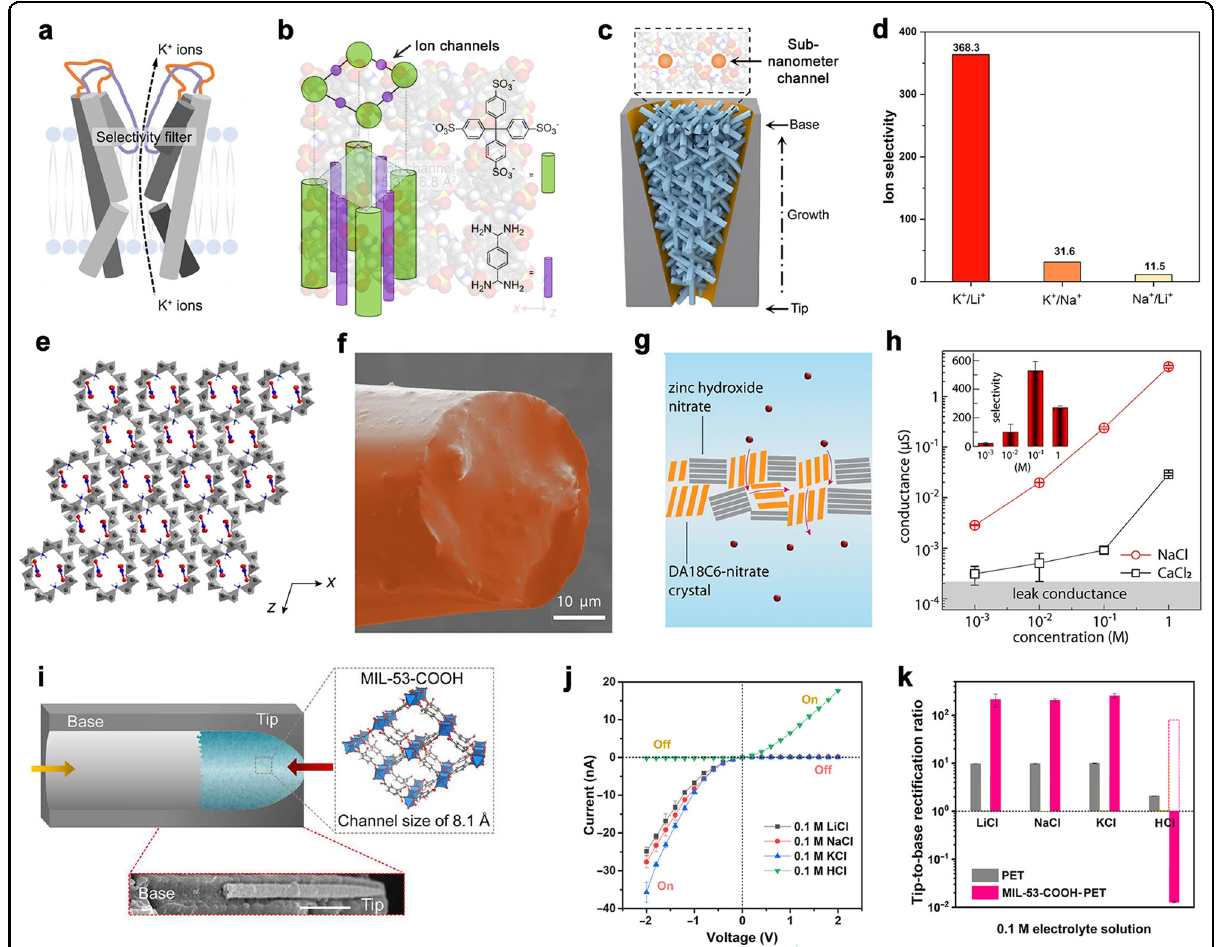
Fig. 3 Porous crystal-based arti fi cial nanochannels with pore-in-pore structures. a Schematic of KcsA K + channels. b Crystalline porous organosulfonate-amidinium salts (CPOSs) and the presented channel. c A single conical PET nanochannel with assembled CPOSs inside. d Ion selectivity of the CPOS-PET nanochannel. Reproduced with permission 22 . CC BY (https://creativecommons.org/licenses/). e Crystal structure of crown ether (1,10-diaza-18-crown-6-ether). f Scanning electron microscope (SEM) image of a micropipette tip fi lled with crown ether crystal. g Schematic of ion transport through crown ether crystal channels. h The conductance of NaCl and CaCl 2 . The inset displays the calculated ion selectivity. Reproduced with permission 39 . CC BY (https://creativecommons.org/licenses/). i Structure of MIL-53-COOH MOF and its assembly in a bullet-like PET nanochannel. I ‒ V curves ( j ) and the tip-to-base ion recti fi cation ratios ( k ) of the MIL-53-COOH-PET nanochannel in different electrolytes. Reproduced with permission 10 . CC BY 4.0